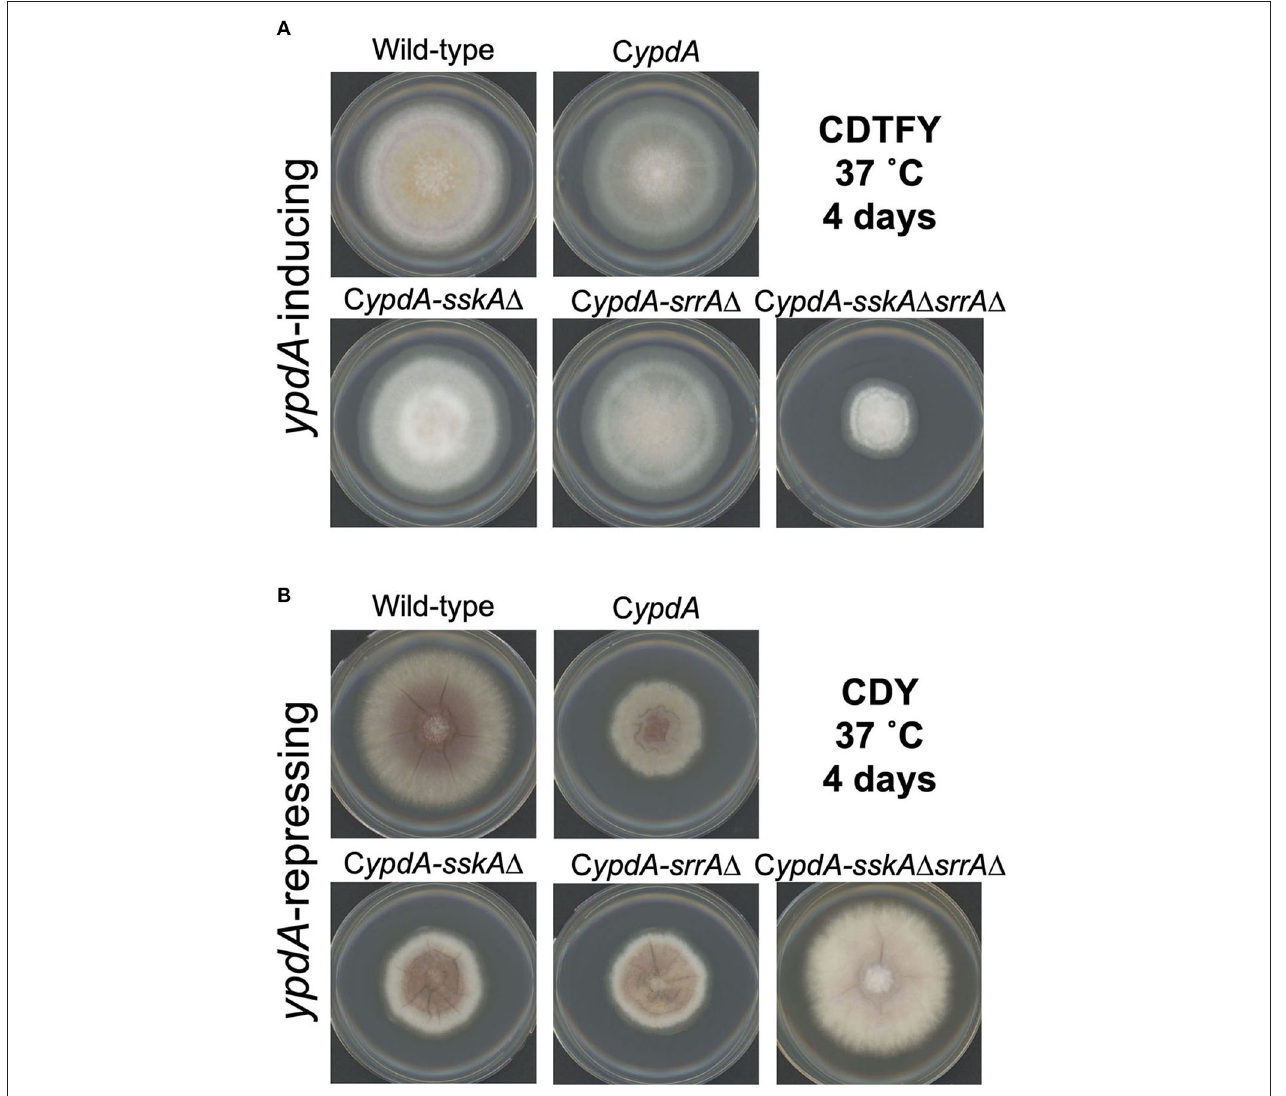
FIGURE 4 | Mycelial growth of Aspergillus nidulans wild-type, C ypdA , and its derivative strains on ypdA -inducing and -repressing plates. Conidia (1 × 10 4 ) of each strain were inoculated at the center of agar plates with ypdA -inducing CDTFY medium (A) or ypdA -repressing CDY medium (B) and incubated at 37 ◦ C for 4